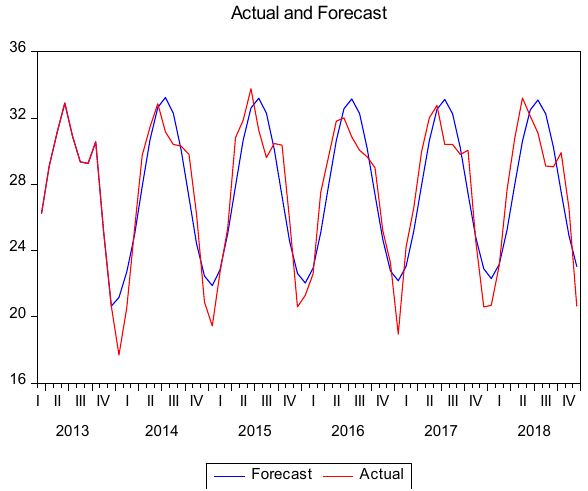
Figure 6. Graph depicting observed and forecasted values of time series.